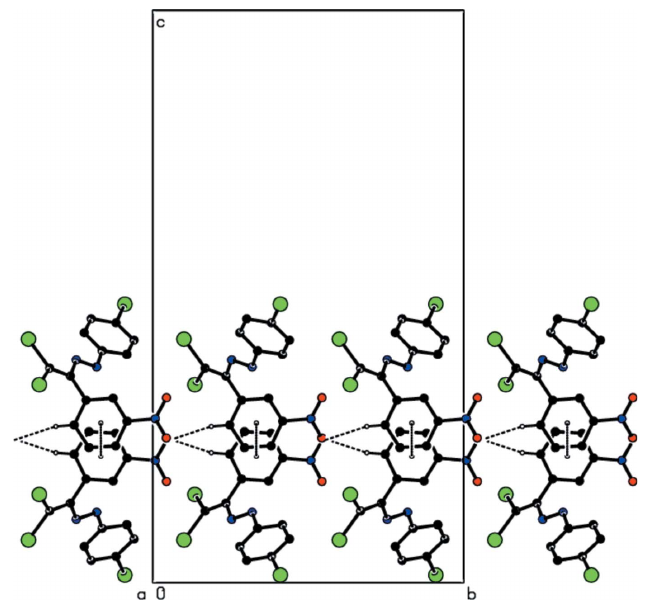
Figure 2 View down the a -axis of the C—H (cid:2)(cid:2)(cid:2) O and (cid:2) – (cid:2) interactions (dashed lines) in the title compound.